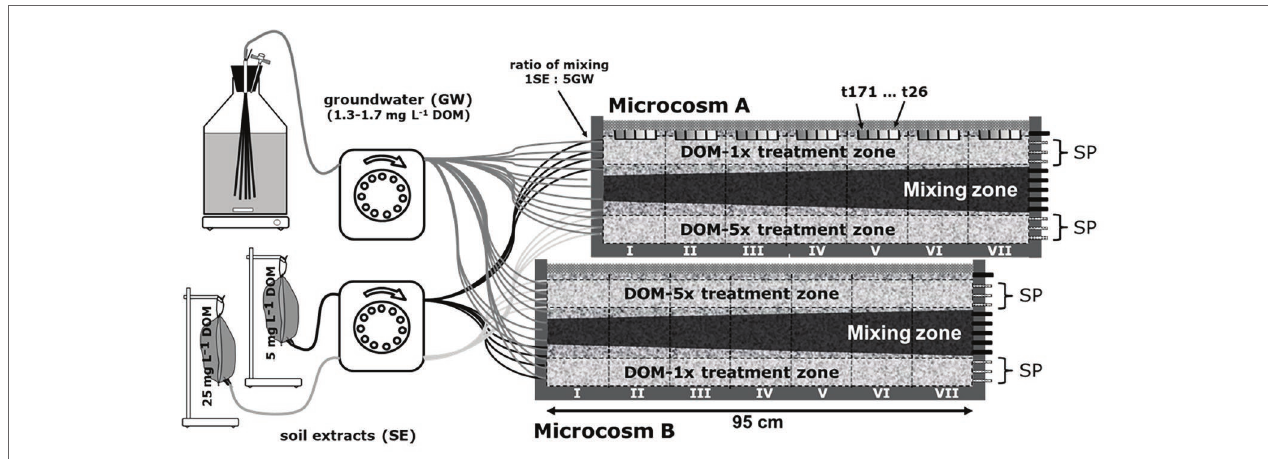
FIGURE 1 | Experimental setup of the 2D microcosms. Two microcosms were run in parallel. Both microcosms were supplied with feeding solution DOM-1x, DOM-5x, and groundwater. In microcosm A, DOM-1x was infiltrated to the top zone, groundwater to the middle zone, and DOM-5x to the bottom zone. In microcosm B, the order was in reverse. DOM-1x and DOM-5x were supplied through four adjacent inlet ports at the bottom and top of the microcosm, separated by three ports receiving only groundwater. DOM-1x and DOM-5x were composed from soil extract (low and high conc.) and groundwater mixed 5:1 at the inlets to the microcosm. For water sampling, only the outflow of the three top and bottom ports (sampling ports; SP) was used. The two sediment zones receiving extra dissolved organic matter (DOM) and traversing each of the microcosms in a longitudinal direction are termed “treatment zones” (horizontal dashed lines). Vertical sediment sections are termed segments (segments I–VII, vertical black lines). Sediment was collected regularly in tanks A and B from the top (location is highlighted by the gray bars in microcosm